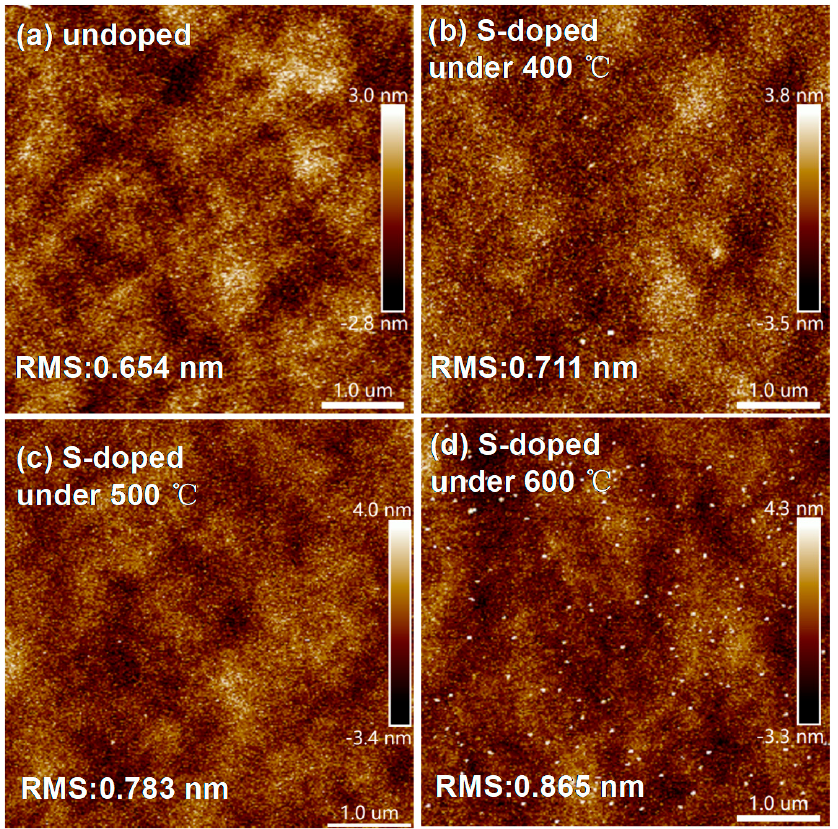
Figure 3. AFM images of the HfOx films of ( a ) undoped and S-doped at ( b ) 400 °C, ( c ) 500 °C, and ( d ) 600 °C.